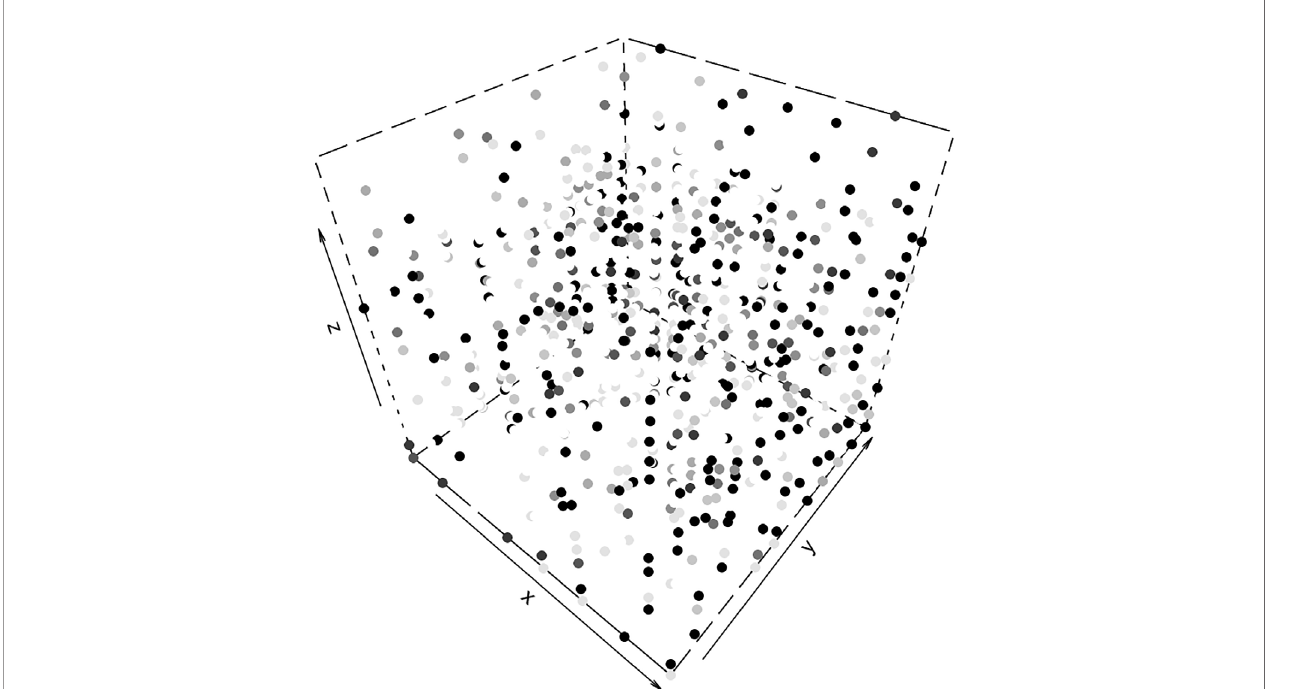
FIGURE 3 | A grey-level coded presentation of the mutant fractions at 8 × 12 sites on s = 18 slices. The total number of samples is 1,728. The data are for the fi rst marker of the Leydig cell tumor. The darkness of the grey scale indicates the mutant fraction (white = 0%, black = 100%). One can discern that at the center of the cubic structure, the mutational marker seems to be more prevalent and more dense. But high mutant fractions occur at sites throughout the